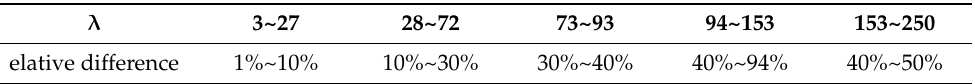
Table 4. The relative difference between the proposed stability factor in this paper and the code for design of thin steel structures (GB